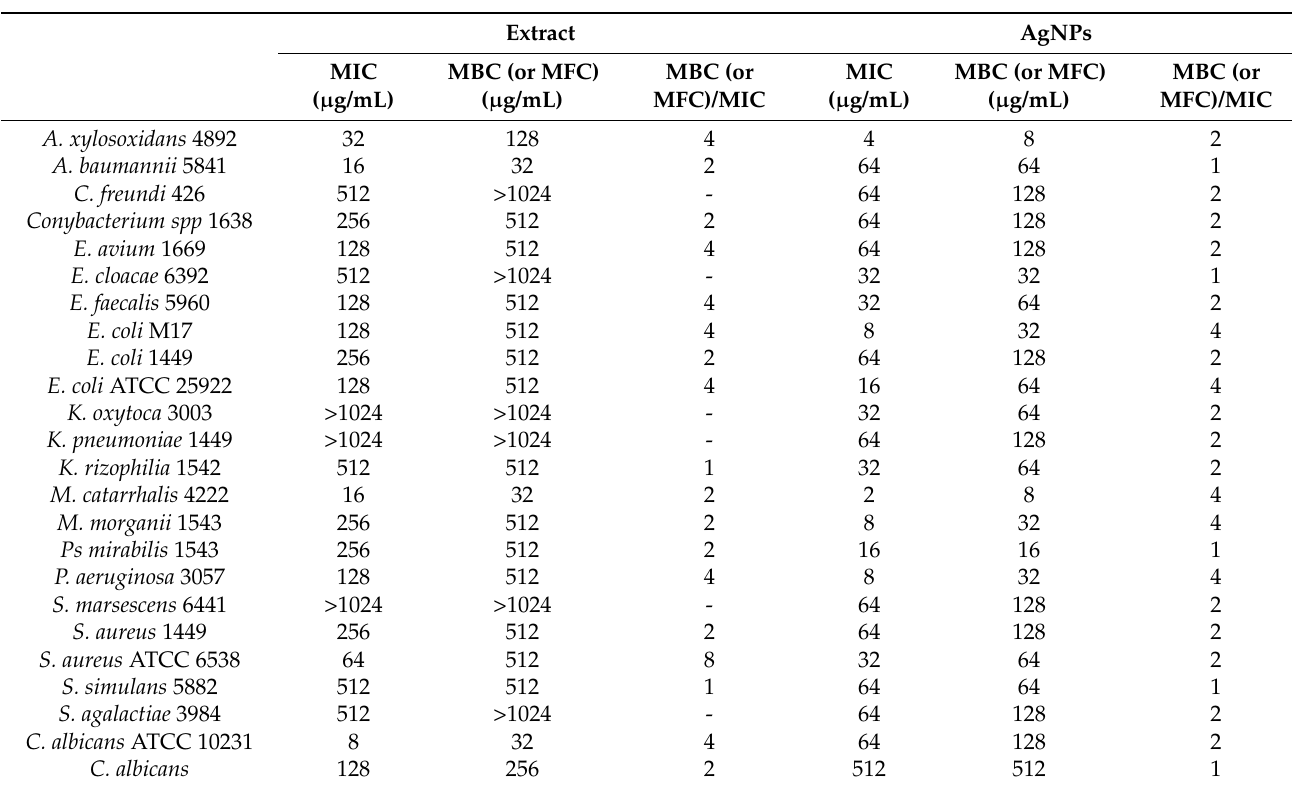
Table 7. Minimal inhibitory concentrations (MICs), minimal bactericidal concentrations (MBCs), and minimal fungicidal concentrations (MFCs), of E. Chloranta bark extract and its green-synthetized AgNPs. Extract